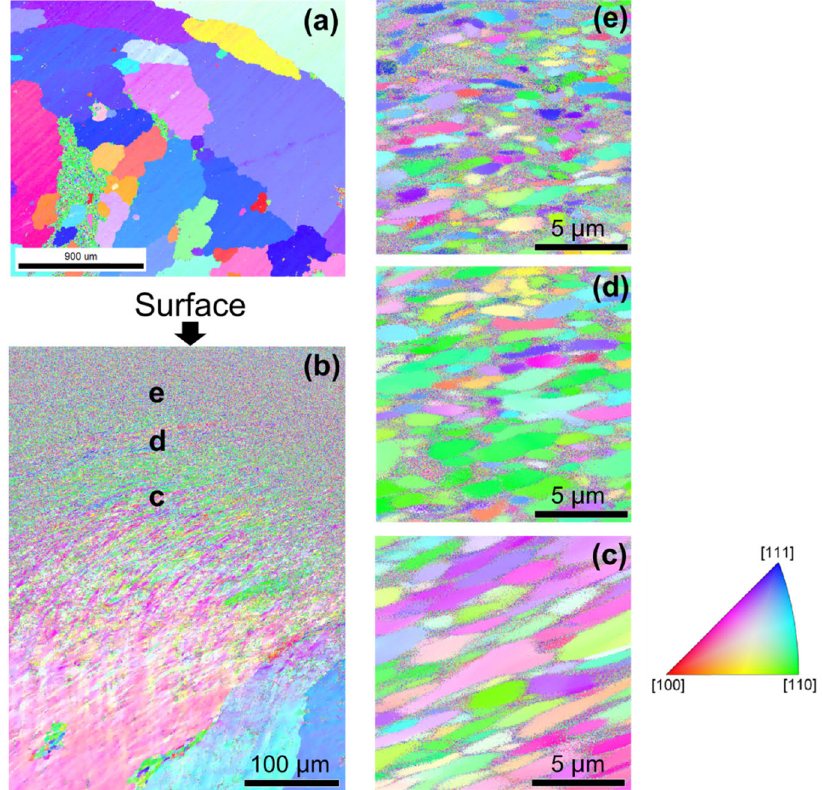
Fig. 1 Orientation maps of Al – Mn alloys. a CG Al – Mn sample, b GG Al – Mn sample, c ~150 μ m to surface of GG Al – Mn sample, d ~100 μ m to surface of GG Al – Mn sample, and e ~50 μ m to surface of GG Al – Mn sample.